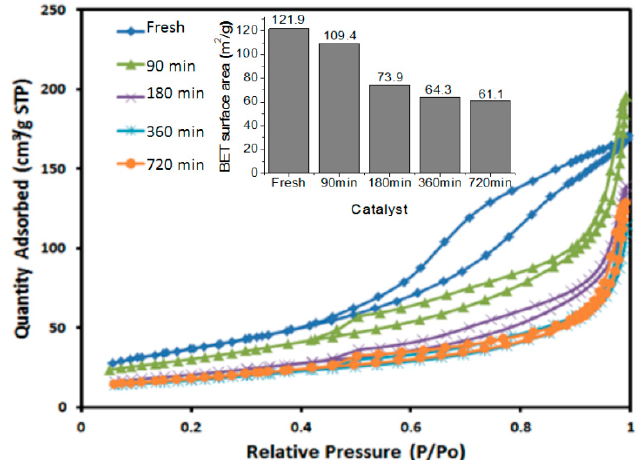
Figure 4. N 2 adsorption-desorption isotherms and variation of specific surface areas for fresh, spent, and spent/regenerated catalysts at different reaction times.